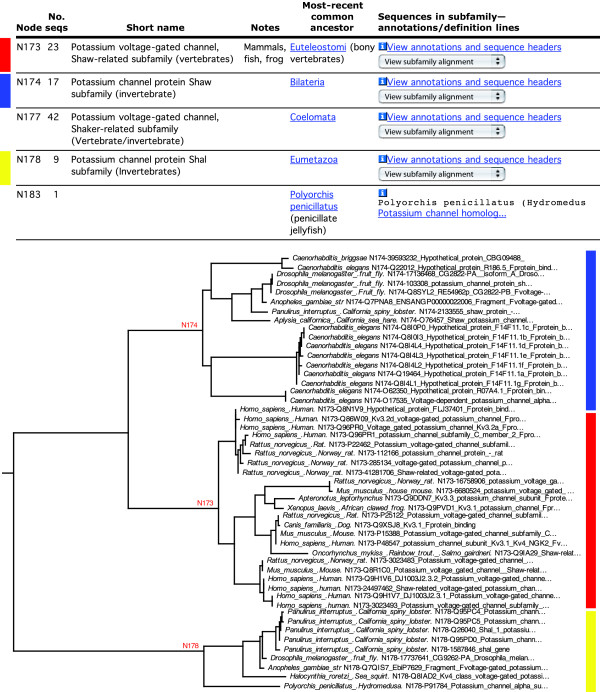
SCI-PHY subfamilies correspond closely to conserved phylogenetic clades. Shown here is the Maximum Likelihood (ML) tree and SCI-PHY subfamilies for the PhyloFacts book 'Voltage-gated K+ channels, Shaker/Shaw subtypes'. A branch of the ML tree is displayed, labeled with the corresponding SCI-PHY subfamilies. Subtrees containing sequences from a single subfamily are colored to show the correspondence between the SCI-PHY subfamilies and the ML tree.